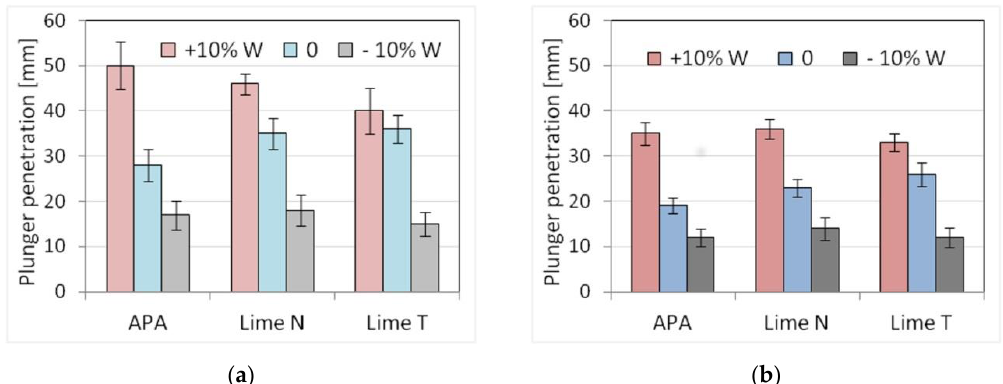
Figure 11. Influence of the errors in water dosing on the consistency tested by plunger penetration method of ( a ) plaster, ( b ) masonry mortars.